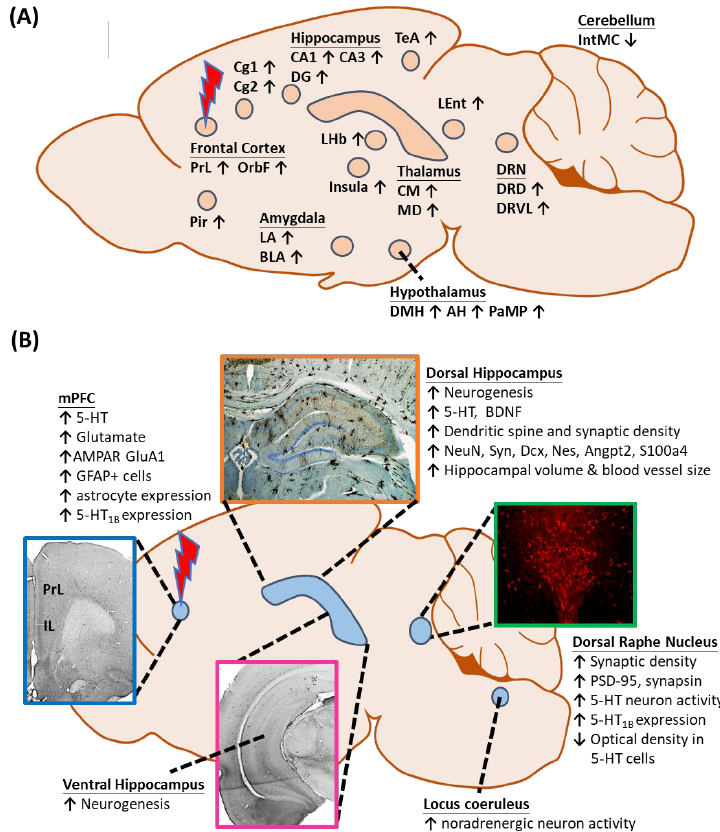
Figure 1. ( A ) Changes in local and distal neuronal activity after electrical stimulation of the ventromedial prefrontal cortex. ( B ) Neuroplasticity-dependent and -independent changes in different structures following vmPFC-DBS. Abbreviations: AH, anterior hypothalamus;